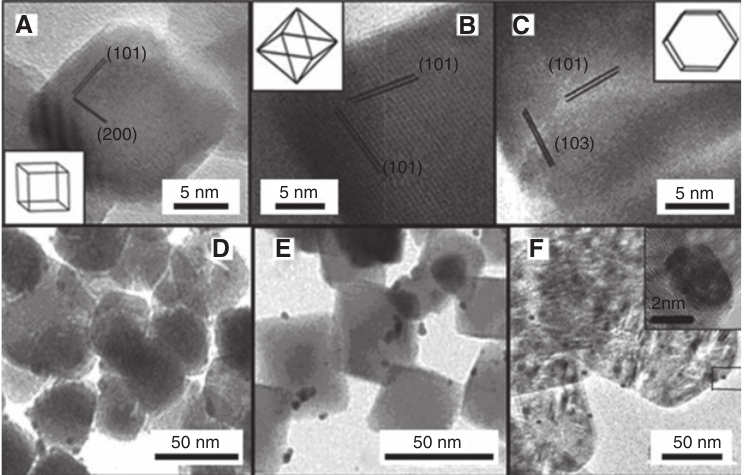
O CPs (cubic), (B) Mn 3 4